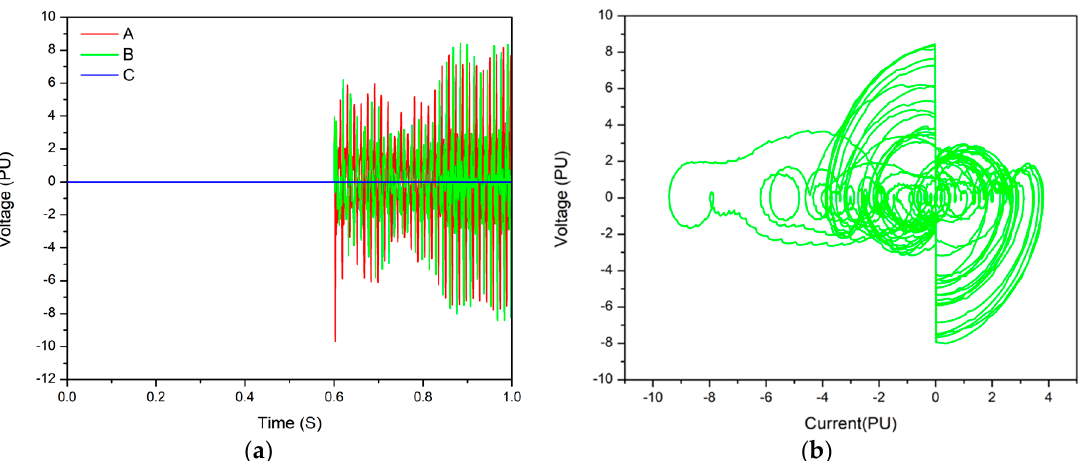
Figure 8. The ferroresonant results during energization at 0.6 secs on the SCIG wind turbine: ( a ) Voltage waveform showing overvoltage in phase A and B; ( b ) Phase plane diagram of phase B depicting chaotic mode .